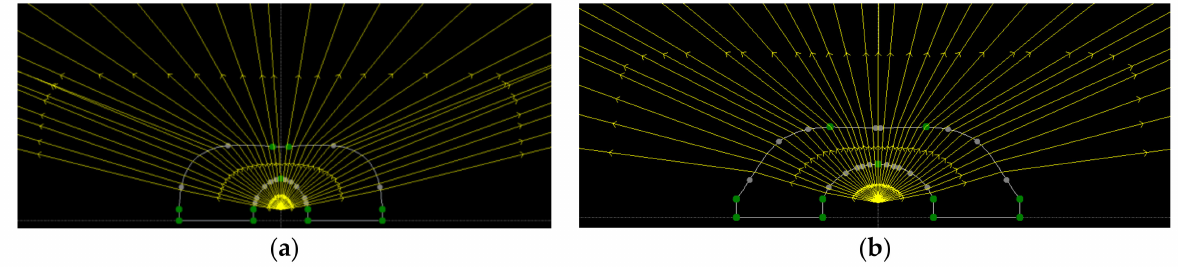
Figure 11. The light path of the roadway lighting through the lens: ( a ) Type A; ( b ) Type B.